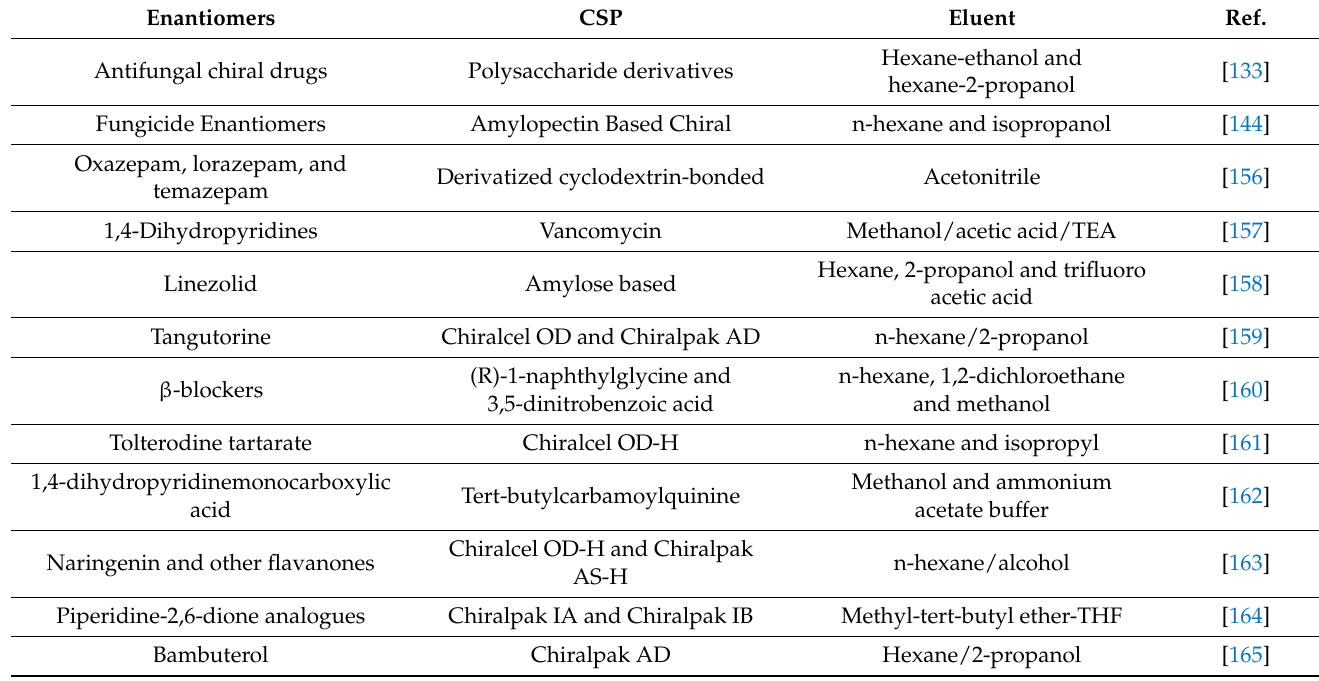
Table 9. Experimental studies of enantioresolutions applying HPLC